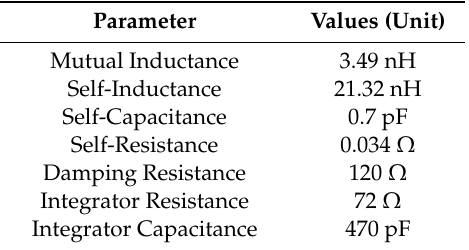
Table 2. Circuit parameters of current sensor.